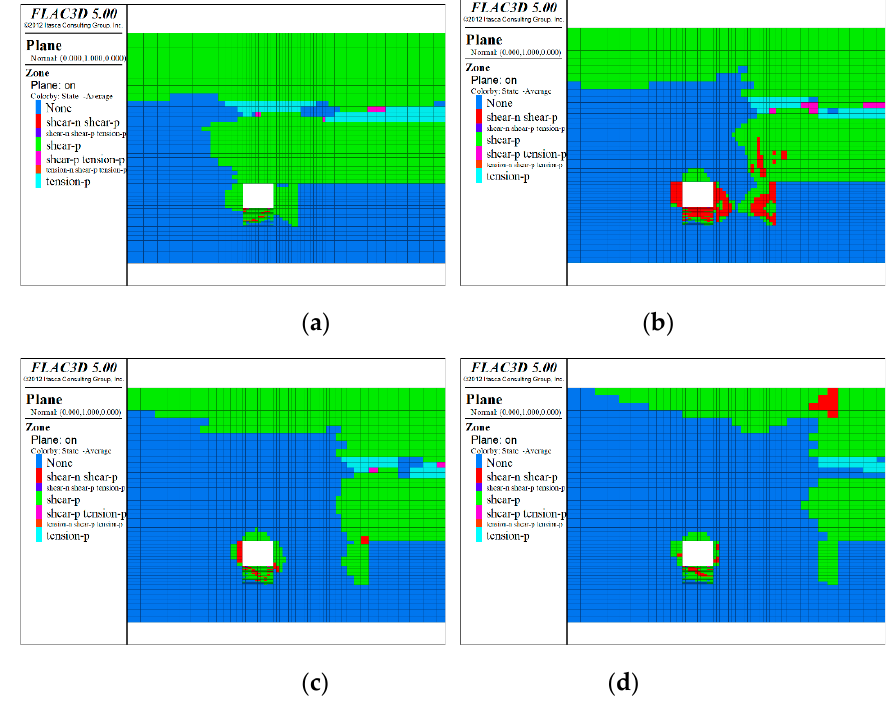
Figure 6. Failure depth of floor at different widths of coal pillars. ( a ) Coal pillar of 4 m wide; ( b ) coal pillar of 10 m wide; ( c ) coal pillar of 15 m wide; ( d ) coal pillar of 20 m wide.